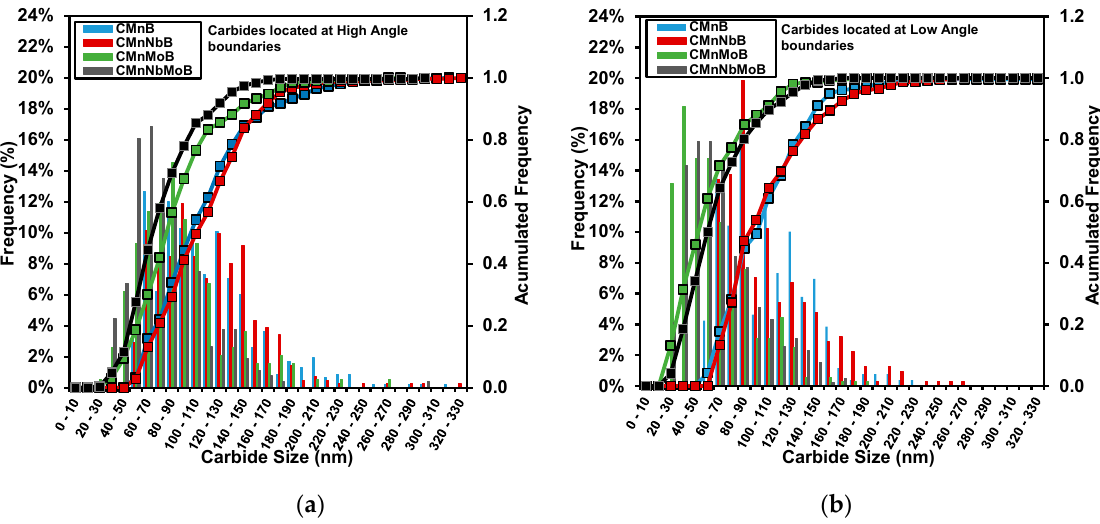
Figure 8. Comparison between carbide size distributions corresponding to the different steels and considering both grain boundaries: ( a ) carbides located at high-angle boundaries and ( b ) carbides located at low-angle boundaries. Table 4. Measured mean carbide sizes and carbide densities considering total carbide population (sum of high-angle and low-angle boundaries).